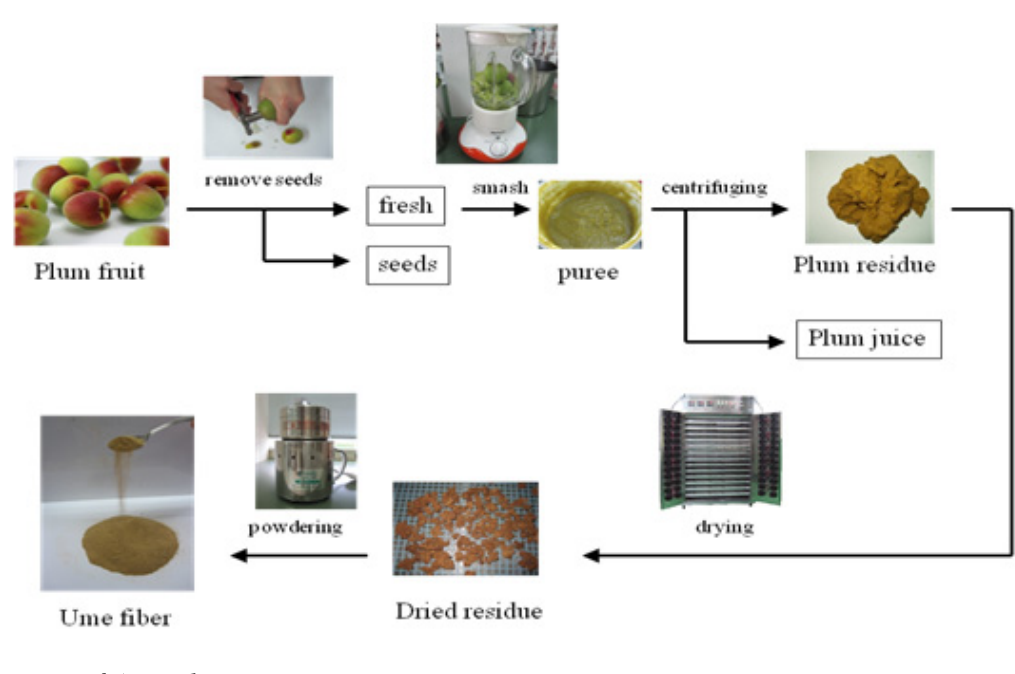
Figure 5. The method of manufacturing ume